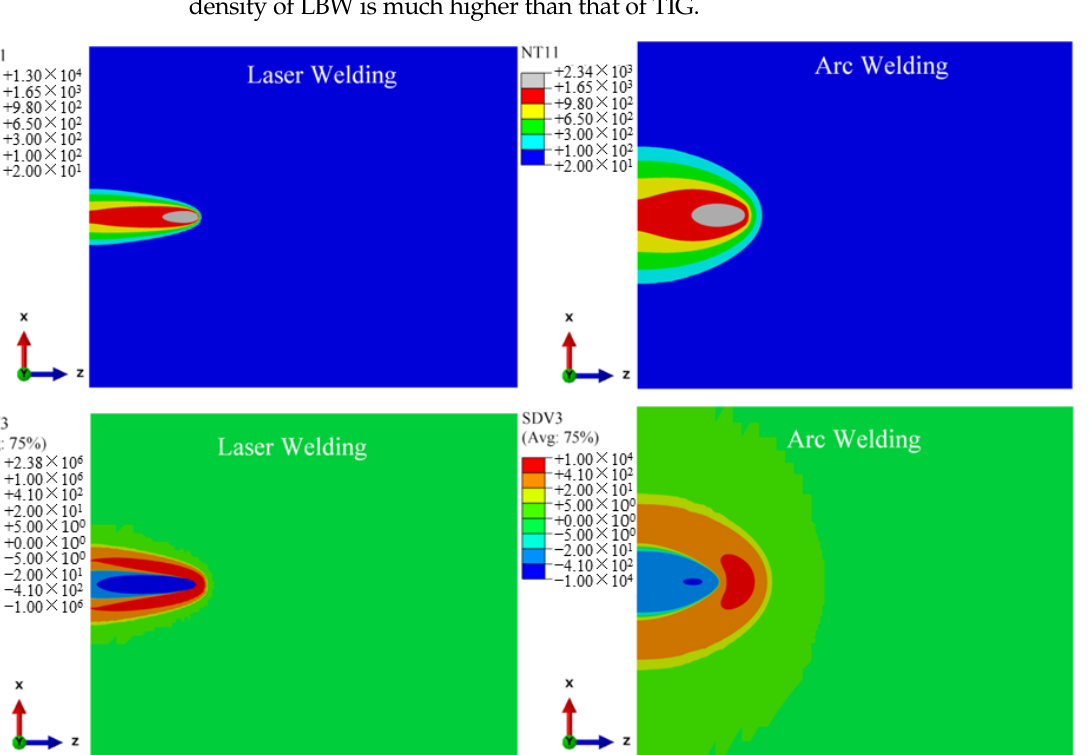
Figure 14. Historical peak temperature of welding process: ( a ) LBW weldment, ( b ) TIG weldment. According to the solid-state phase transformation equation of titanium alloy in Section 3.3, the field variables affecting the phase transformation process of Ti-6Al-4V are mainly the current temperature NT11 ( ◦ C), cooling/heating rate SDV3 ( ◦ C/s) and historical peak temperature SDV4 ( ◦ C). These three variables are used as the criteria of the phase transformation to calculate the volume fraction of each phase component in the weld seam during welding. According to the research of Gao et al. (2013) [2], Committee et al. (2004) [21], Elmer et al. (2004) [20] and Squillace et al. (2012) [19], the cooling rate has a great influence on welding phase transformation. Figures 15–17 are the distribution cloud diagrams of the current temperature NT11 ( ◦ C) and cooling/heating rate SDV3 ( ◦ C/s) at different times during welding. Comparing the temperature distribution of NT11 between LBW and TIG welding, it can be seen that the temperature distribution range of LBW is significantly narrower than that of TIG and that the temperature of FZ is much higher than that of TIG welding, which shows that the power density of LBW is much higher than that of TIG.